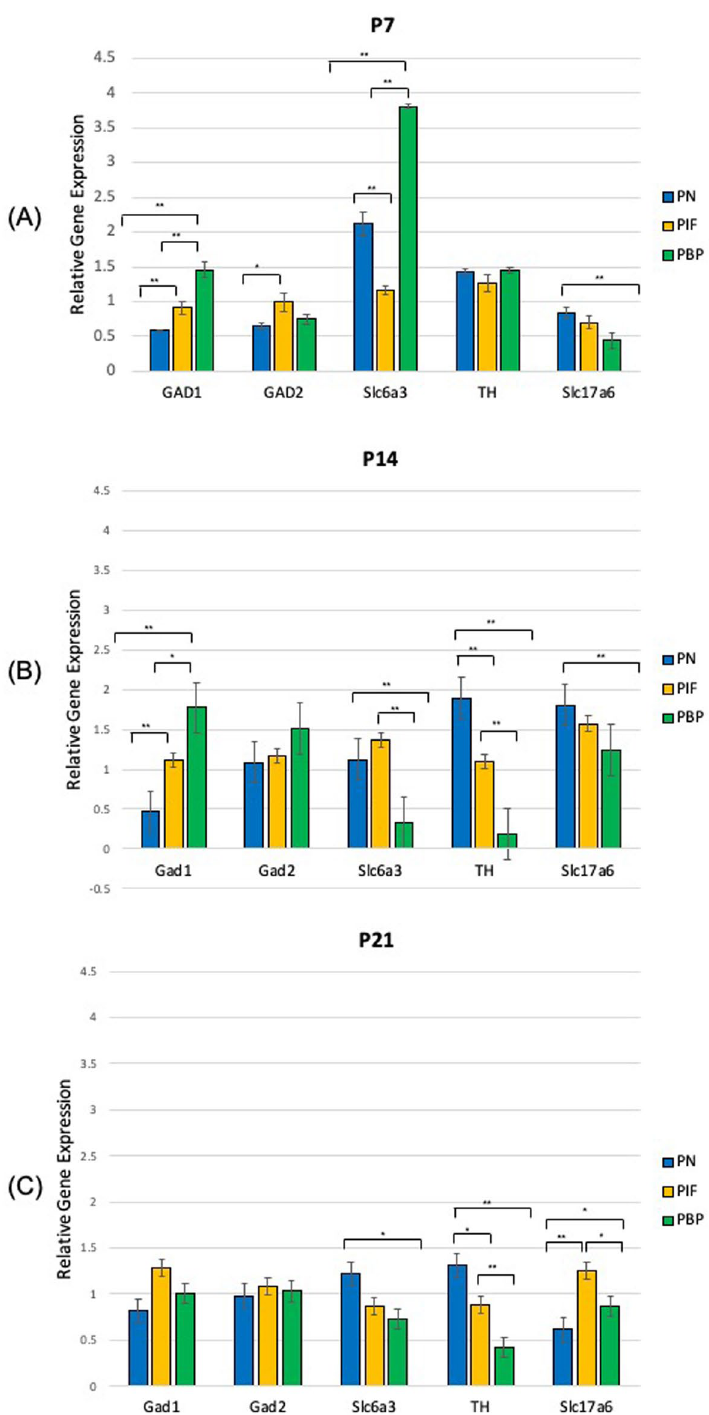
Figure 1. Relative gene expression of GABA, DA, and glutamate markers by sub-region of the VTA following nicotine exposure as compared to the saline group. The results follow qPCR analysis relative to housekeeping gene, GAPDH. Two-way analysis of variance was used to indicate the significance between gene expressions in each sub-regions of the VTA as well as each gene for ( A ) age P7 (nicotine: n = 7; saline: n = 7) ( B ) age P14 (nicotine: n = 20; saline: n = 14), and ( C ) age P21 (nicotine: n = 18; saline: n = 14). *p < 0.05, **p < 0.01, ± standard